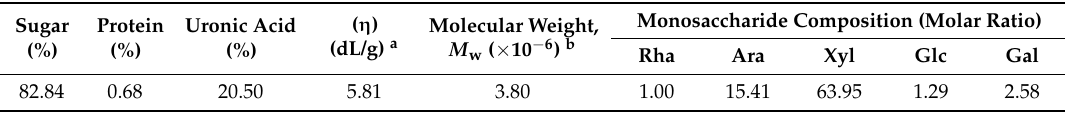
Table 1. Physicochemical properties of PLAP.